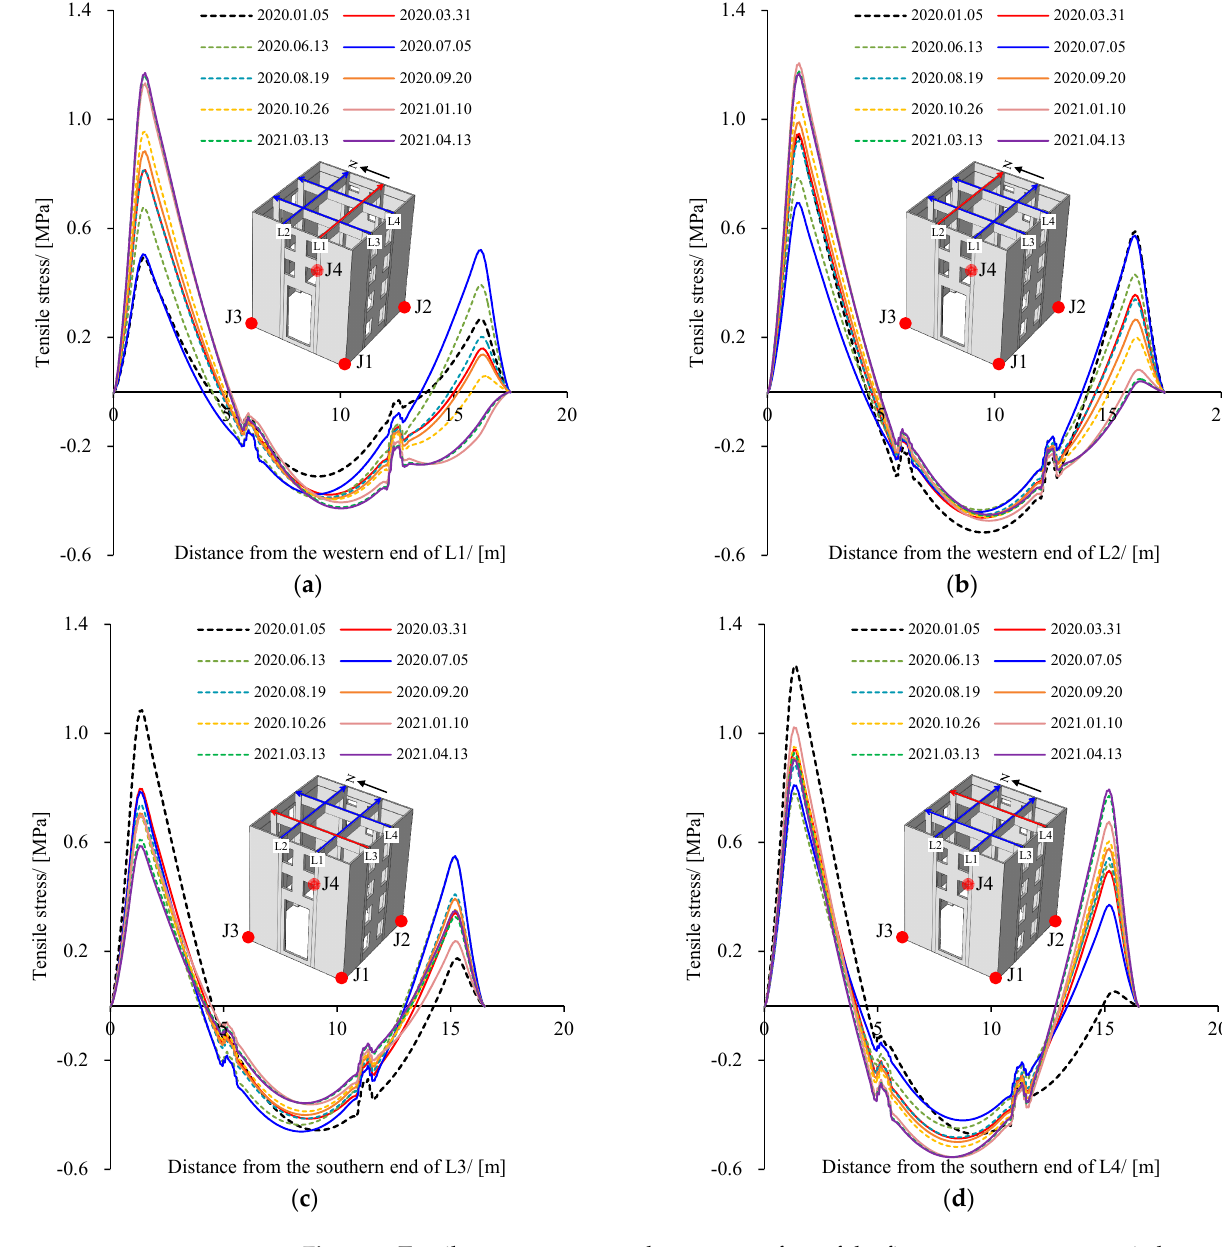
Distance from the southern end of L4/ [m]